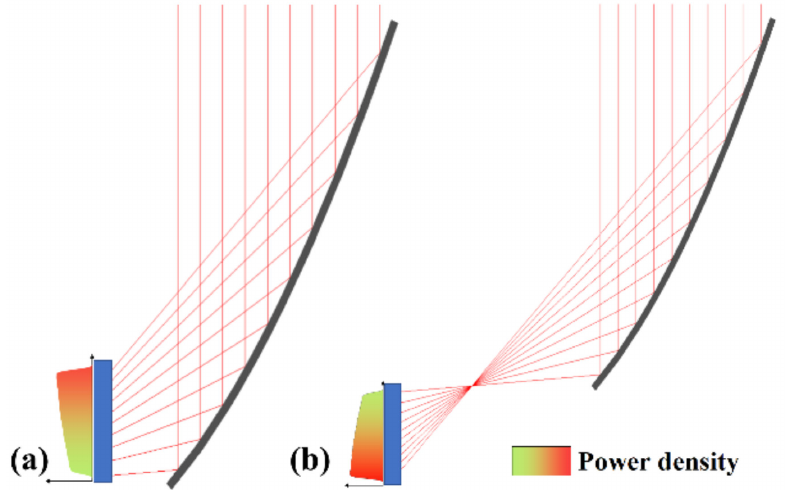
Figure 4. Solar absorption distributions of absorbers along the axial direction: ( a ) A absorber in front of the focus; ( b ) A absorber behind the